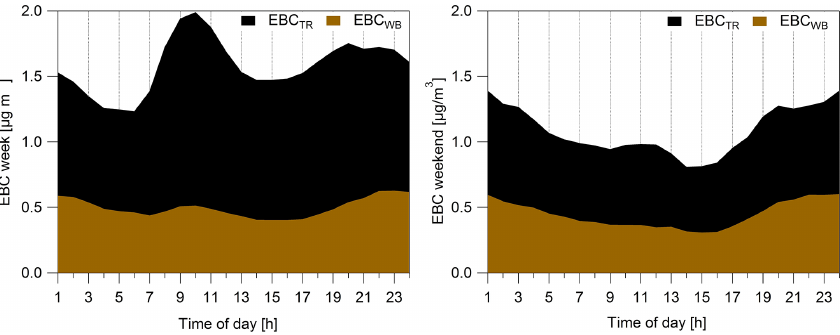
Figure 7. Diurnal cycle at ZUR including 1h winter data from 2009 to 2012. EBC WB and EBC TR were calculated using the best α pair ( α TR = 0.9 and α WB = 1.68) as obtained in Sect. 3.2.1. The split uncertainty between EBC WB and EBC TR ( (cid:49) EBC TR / EBC) is max. 0.04µgm − 3